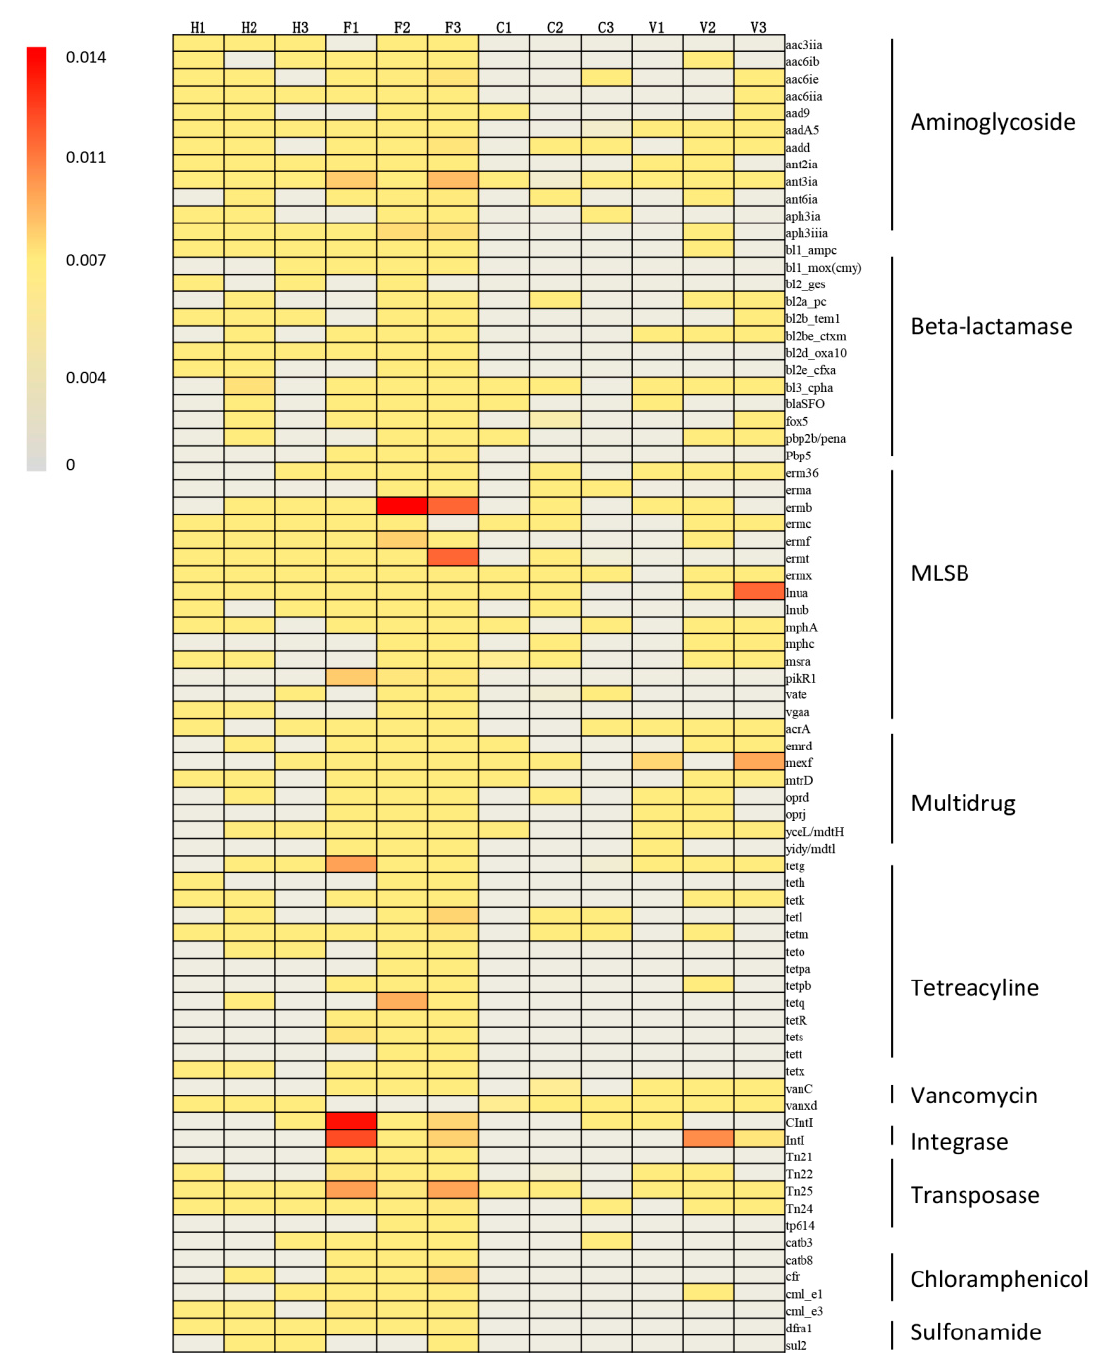
Figure 3. The heat map of detected ARGs. H: hospital; F: farm; C: city residence; V: village residence. MLSB: macrolide–lincosamide–streptogramin B resistance.